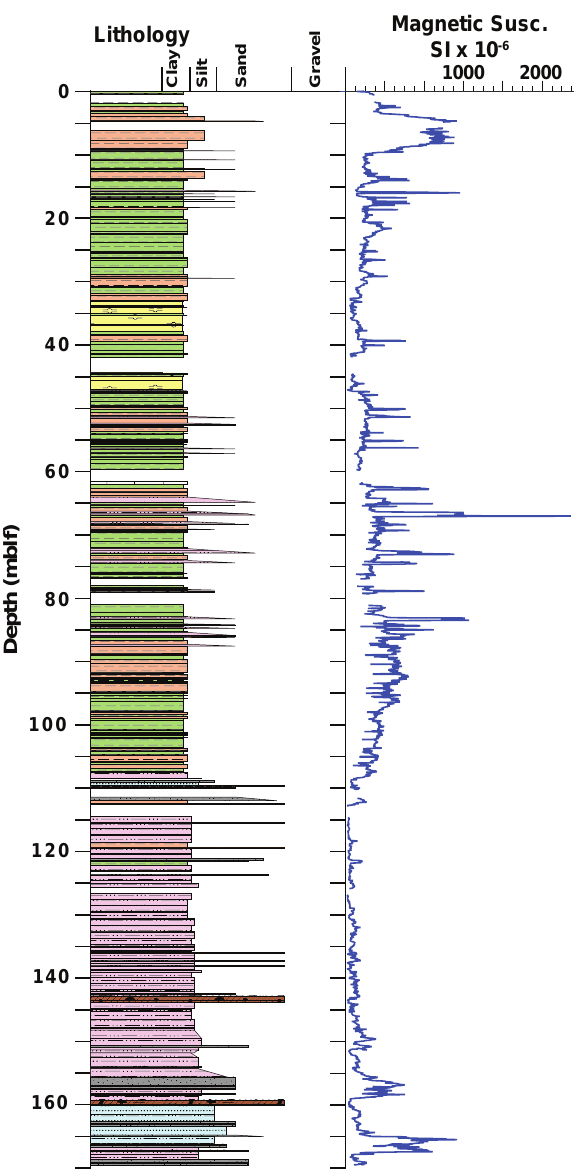
Figure 8. Summary stratigraphy of core TDP-TOW15-3A based on initial core descriptions, and magnetic susceptibility data measured on the whole (unsplit) core from the Geotek MSCL. The key to the lithologic symbols is given in Fig.